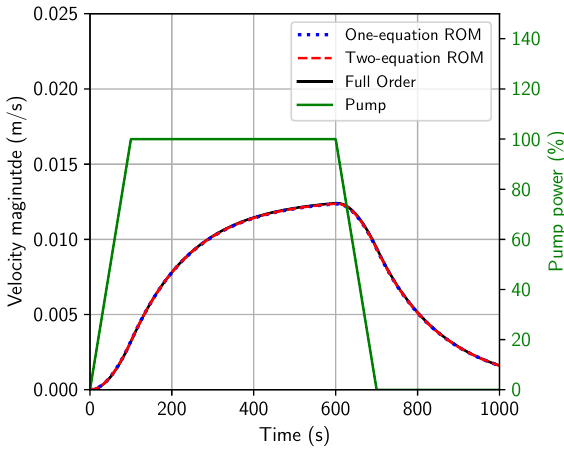
Figure 2: Comparison of the velocity magnitudes at the probe